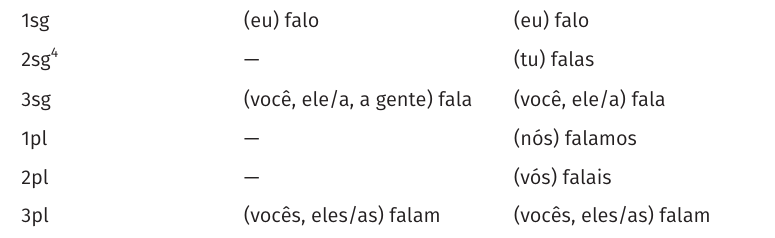
Table 1: Spoken Brazilian and European inflectional